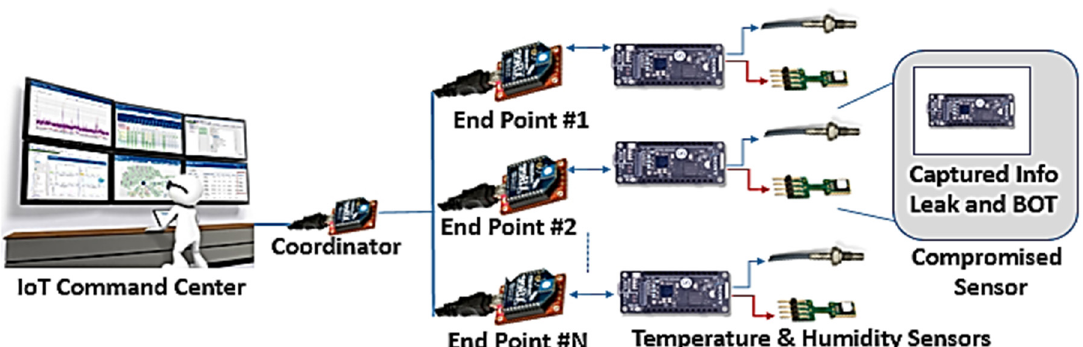
Figure 4. IoT device monitoring and network connectivity.